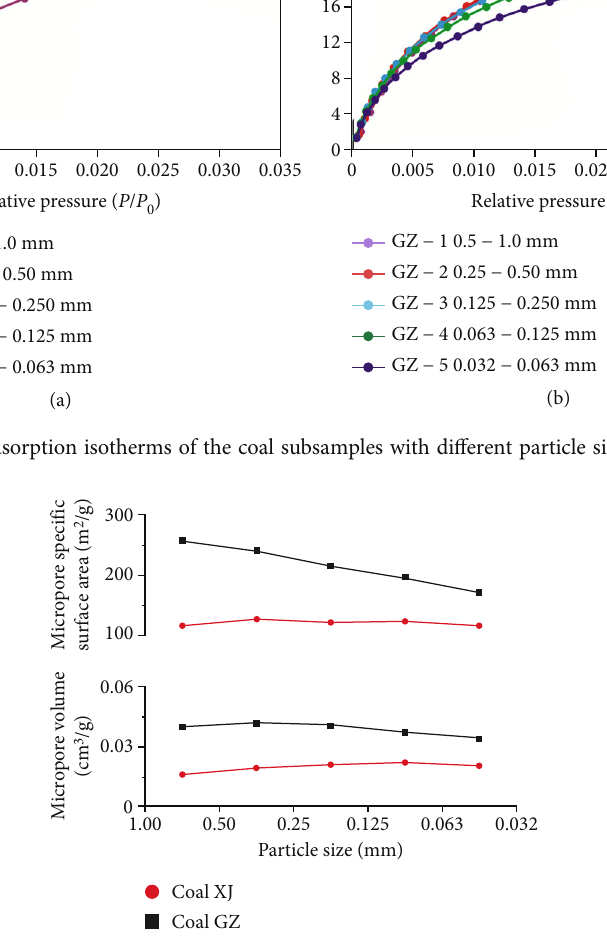
Figure 7: Variations in micropore structure parameters in the coal samples with di ff erent particle